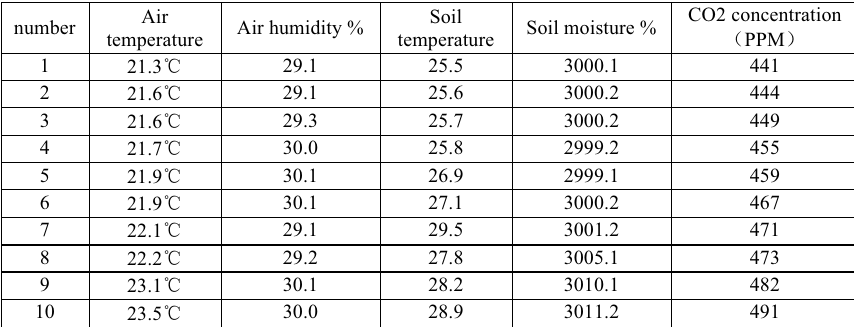
Table 1. The testing results of the Study system